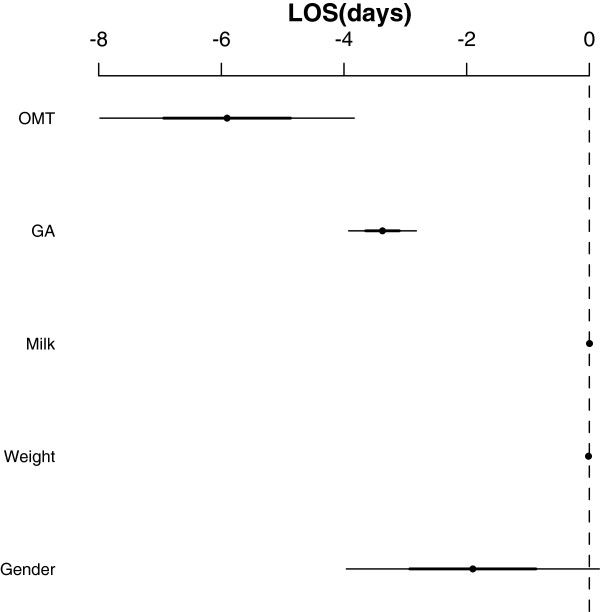
Multivariate linear regression for LOS.